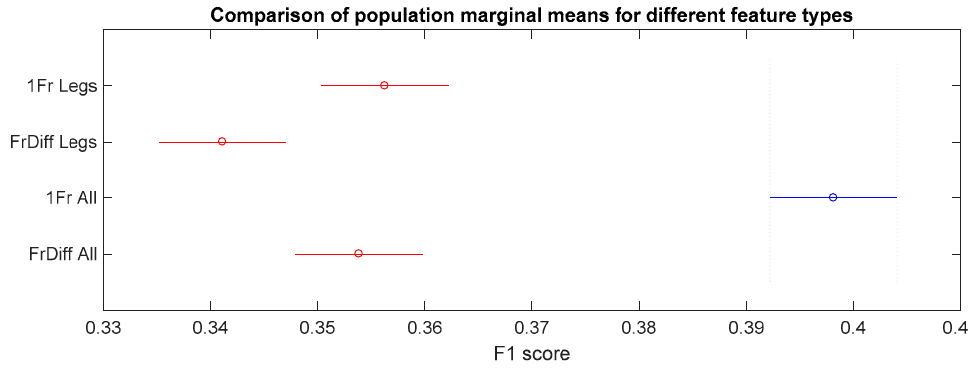
Figure 7. F1 scores for different input feature setups.